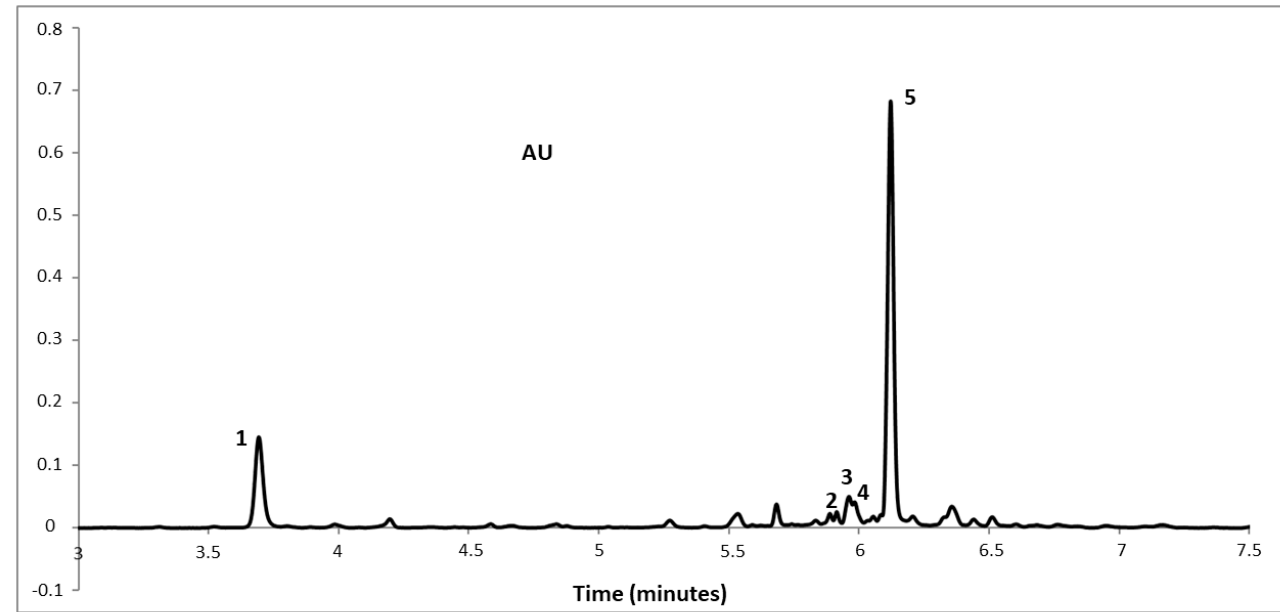
Figure 4. Ultra-High-Performance Liquid Chromatography (UHPLC)-DAD phenolic profile of S. chamaecyparissus extract (recorded at 350 nm) using MAE optimal conditions. Peak numbering is in accordance with Table 4. Table 4. Retention time (R t ), maximum absorption wavelengths in the visible region ( λ max ), mass spectra data, identification, and quantification of the phenolic compounds (optimal conditions obtained for MAE) in S. chamaecyparissus extract